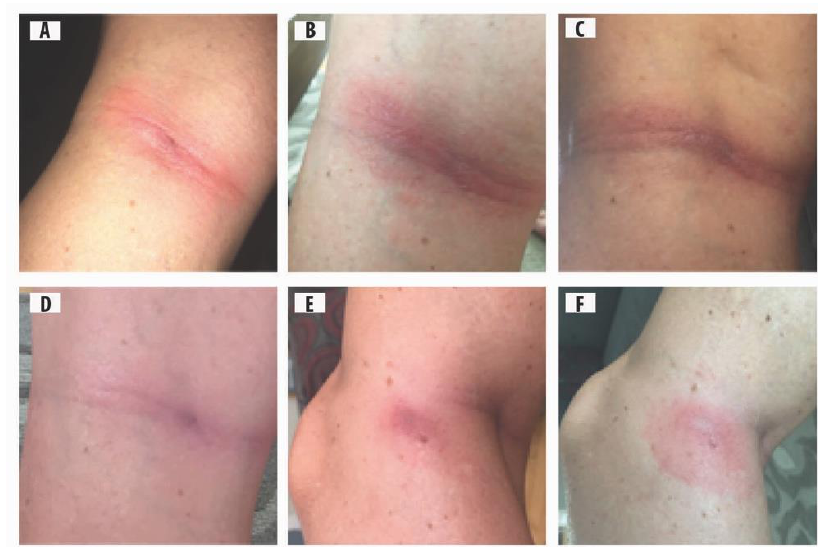
Figure 1. Middle-aged female with two types of rashes on left knee: ( A ) homogeneous rash with a punctum in the centre, 12 d after tick bite; ( B ) early inflammatory phase of acrodermatitis chronica atrophicans (ACA) rash, reddish-blue discoloration with punctum, 14 d after tick bite; ( C ) early inflammatory phase of ACA, more pronounced, extensive purple discoloration, 24 d after tick bite; ( D ) purple discoloration fading as spirochetes disseminate, 52 d after tick bite; ( E ) second rash, homogenous type, on inside of left knee with partial reddish-blue discoloration, punctum from tick bite is apparent; and ( F ) second rash, homogeneous type, purple discoloration fading, and punctum evident.